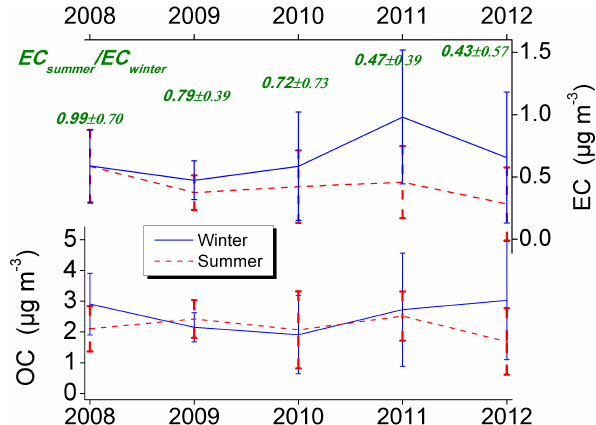
Figure 1. Daily OC and EC concentrations at Penteli station, Athens, for the period May 2008–April 2013.